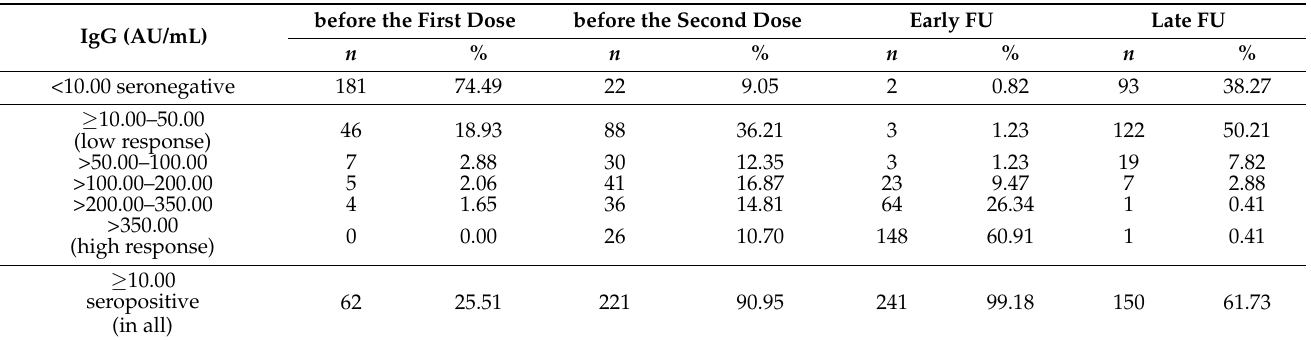
Table 2. Change in the HCWs’ IgG titers before the vaccination with the BNT162b2 vaccine, during the immunization process and early and late follow-up.